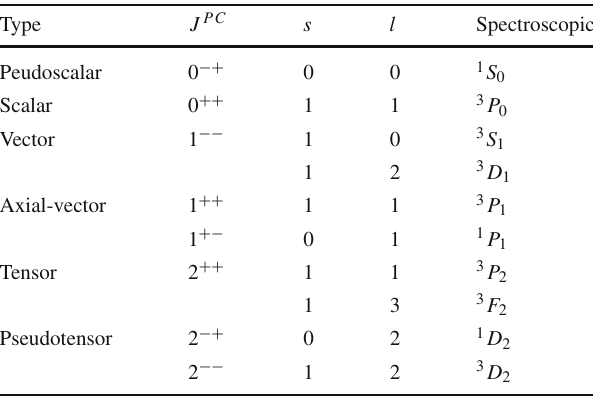
Table 1 Non-exotic quantum numbers and quark-model construction up to meson spin J =